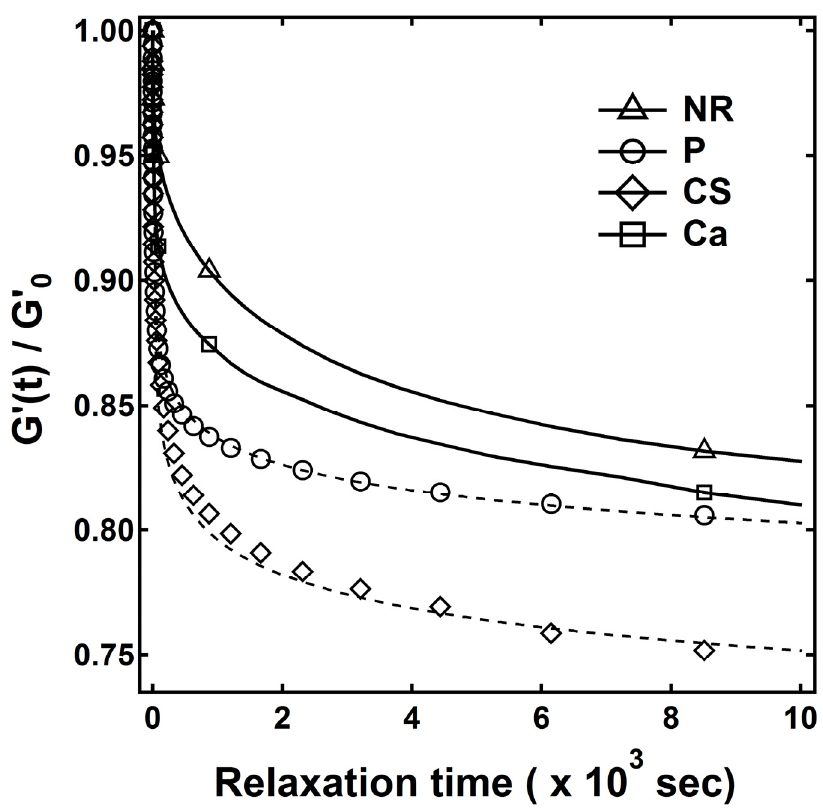
J. Compos. Sci. 2020 , 4 , x FOR PEER REVIEW Figure 12. Stress relaxation moduli at 30 ◦ C and 10% strain. Dash lines are the model fit. Figure 12. Stress relaxation moduli at 30 °C and 10% strain. Dash lines are the model fit. Table 4. Stress relaxation fitting parameters.